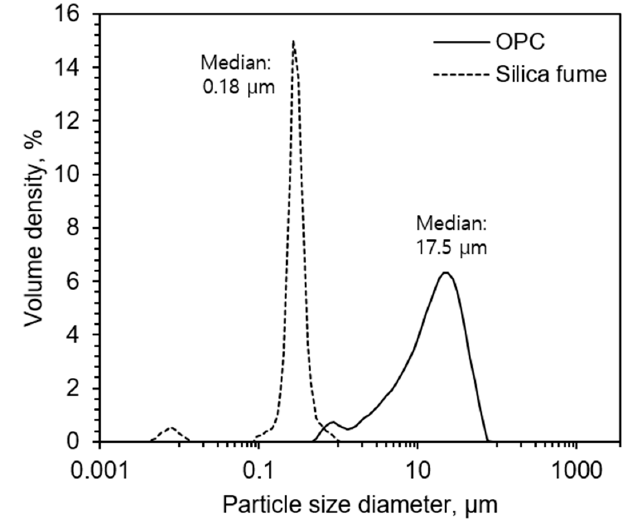
Figure 1. Particle size distribution of cement and silica fume.